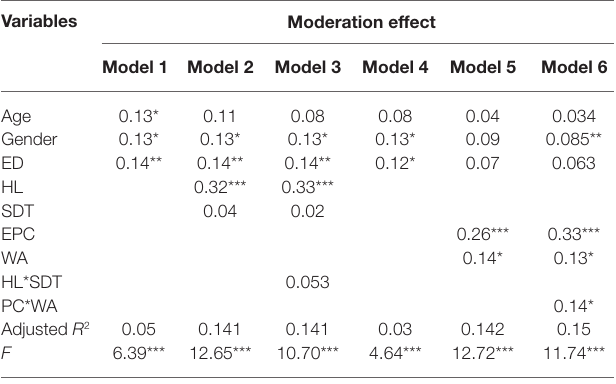
TABLE 3 | Moderation effect of the model. Variables